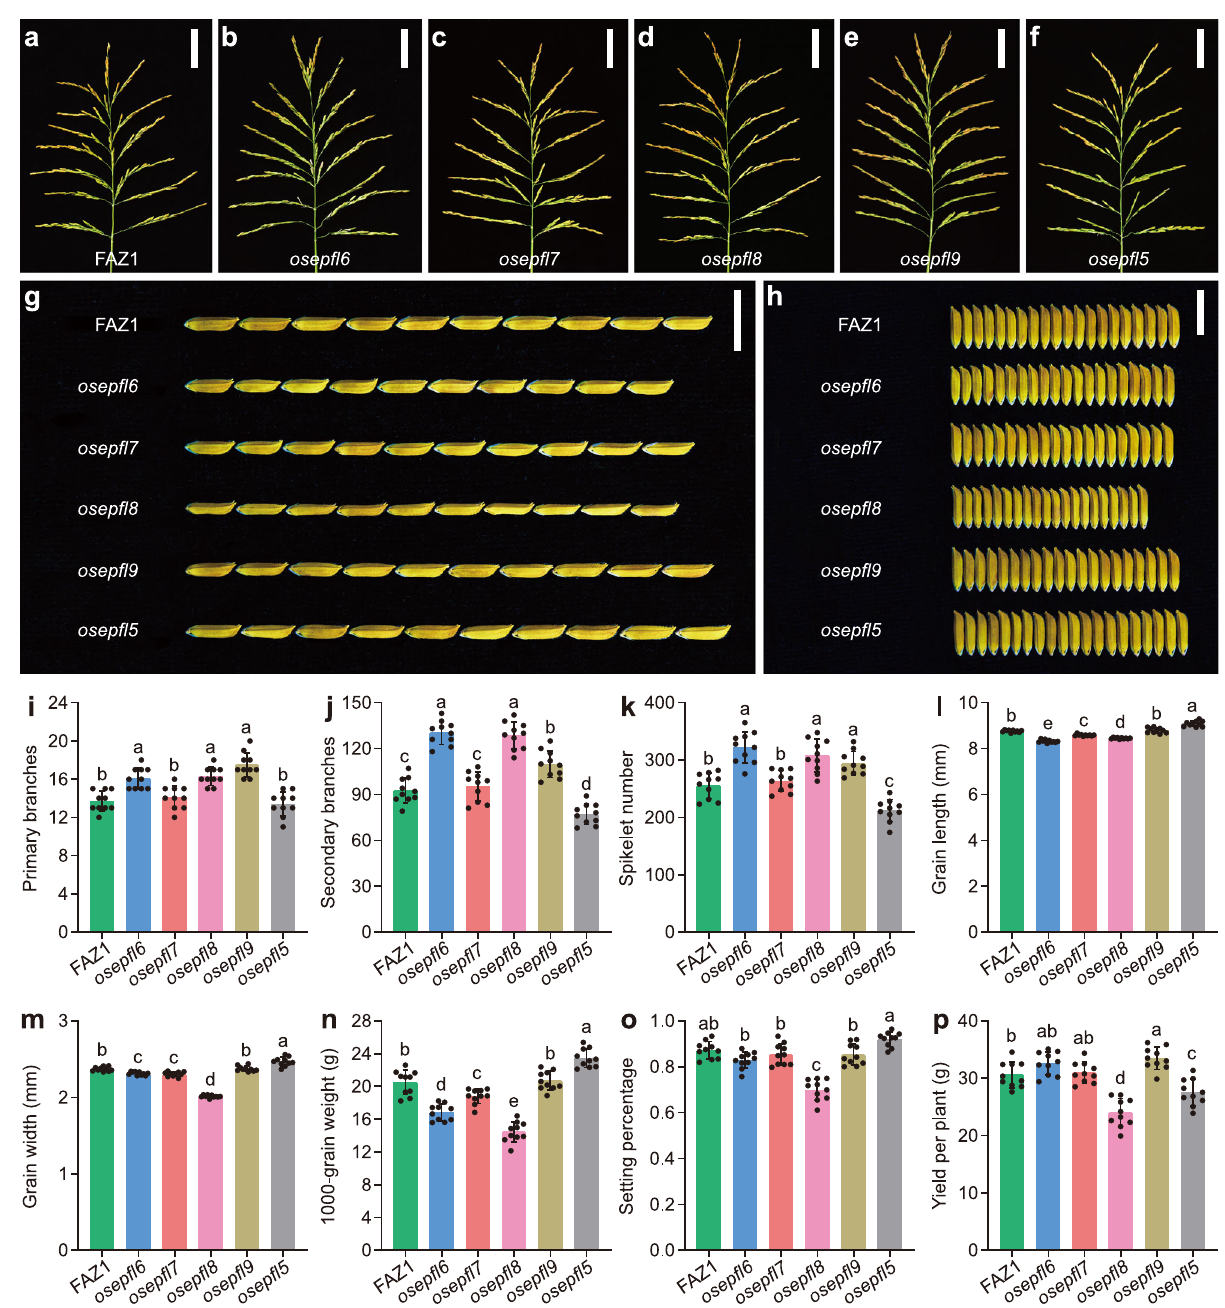
Fig. 1 | OsEPFL6 , OsEPFL7 , OsEPFL8 , OsEPFL9 , and OsEPFL5 are responsible for rice panicle morphogenesis. a – f Rice panicles from FAZ1 ( a ) and the osep fl 6 ( b ), osep fl 7 ( c ), osep fl 8 ( d ), osep fl 9 ( e ), and osep fl 5 ( f ) mutants. Scale bar=5cm. g Comparison of rice grain length between FAZ1 and osep fl 6 , osep fl 7 , osep fl 8 , osep fl 9 , and osep fl 5 mutants. Scale bar=1cm. h Comparison of rice grain width between FAZ1 and osep fl 6 , osep fl 7 , osep fl 8 , osep fl 9 , and osep fl 5 mutants. Scale bar=1cm. i – p Comparisonoftheaveragenumberofprimarybranches( i ),number